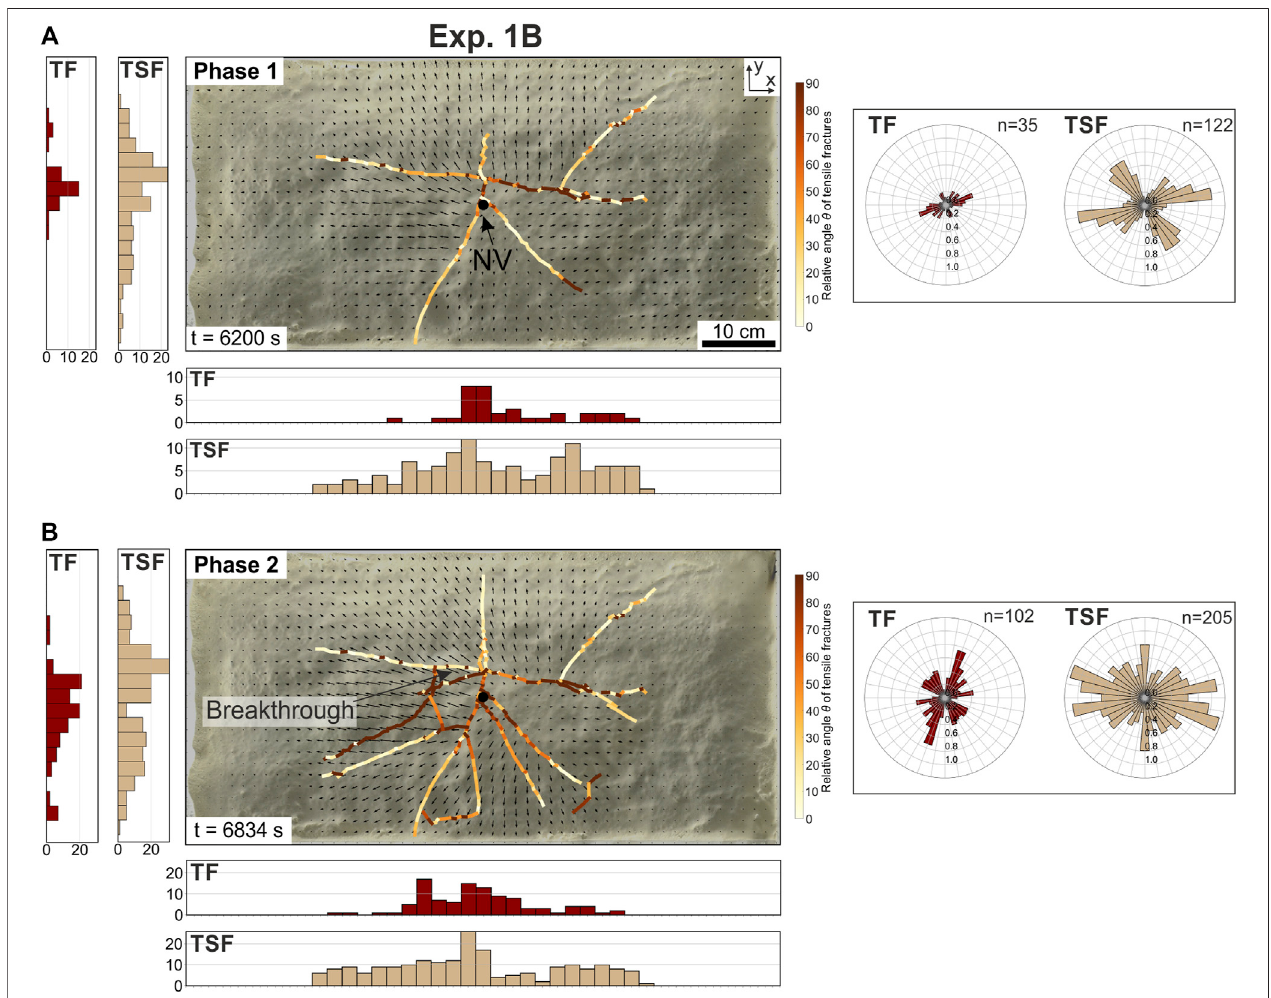
FIGURE 10 | Results of the fracture mode analysis of the 3D experiment 1B for (A) phase 1 and (B) phase 2 showing the opening mode of the fractures color- coded.Thefracturemodeisdeterminedbytherelativeangle θ betweenthestrikeofthefractureandtheclosestdisplacementvector(blackarrows).If θ islargerthan45 ° , thefractureisdominatedbytensileopening(red).Incase θ issmallerthan45 ° ,thefractureisdominatedbytensile-shearmovement(orangetobeige).Notethattracesof compactivefracturewereinvisibleonthesurface.Thebarplotsattheleftandthebottomdisplay theamountofthespeci fi cfracturetypes forcertain intervalsalong the y- and x-axis, respectively. Rose diagrams display the strike angles β of the tensile (TF) and tensile-shear fractures (TSF).